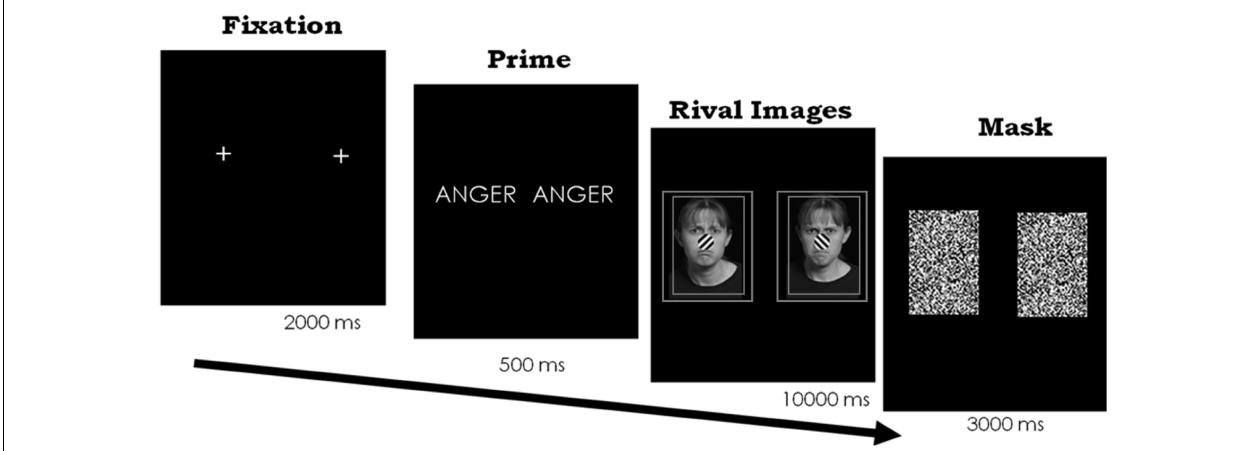
FIGURE 2 | Paradigm and timing for Experiment 1. Frowning face on the left and scowling face on the right. In separate trials, the same two faces also followed the word “sad” and a control word. Each face appeared on the right and left, across trials. Stimuli images are from IAS Lab face set (http://www.affective-science.org) and depict adult participants from Boston College. Participants in this face set gave written and informed consent, including explicit consent to be photographed and their likeness to be